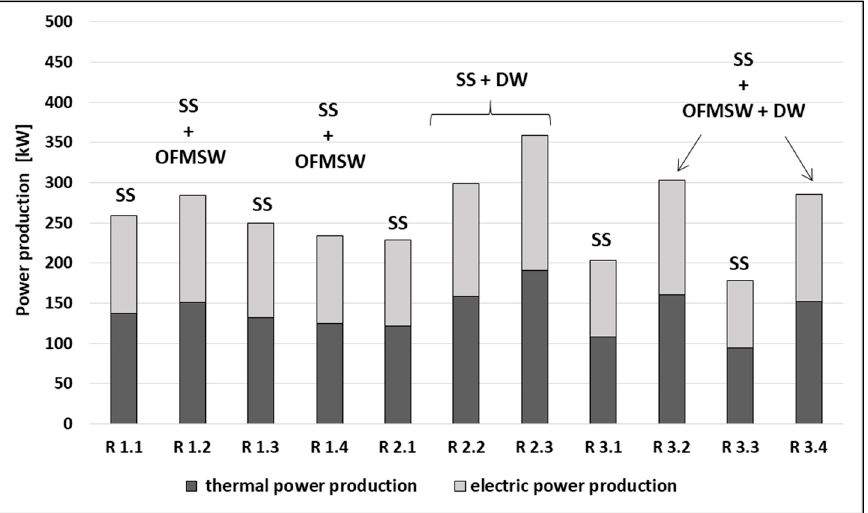
Figure 3. Theoretical thermal/electric power productions in experiments.